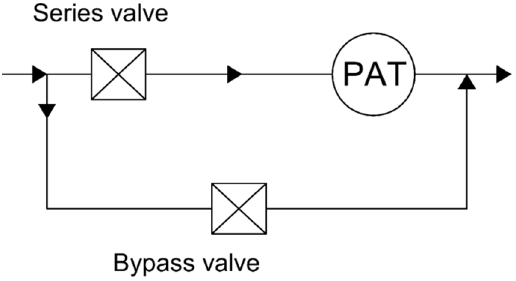
Figure 5. Scheme of the series-parallel hydraulic circuit [36,39].